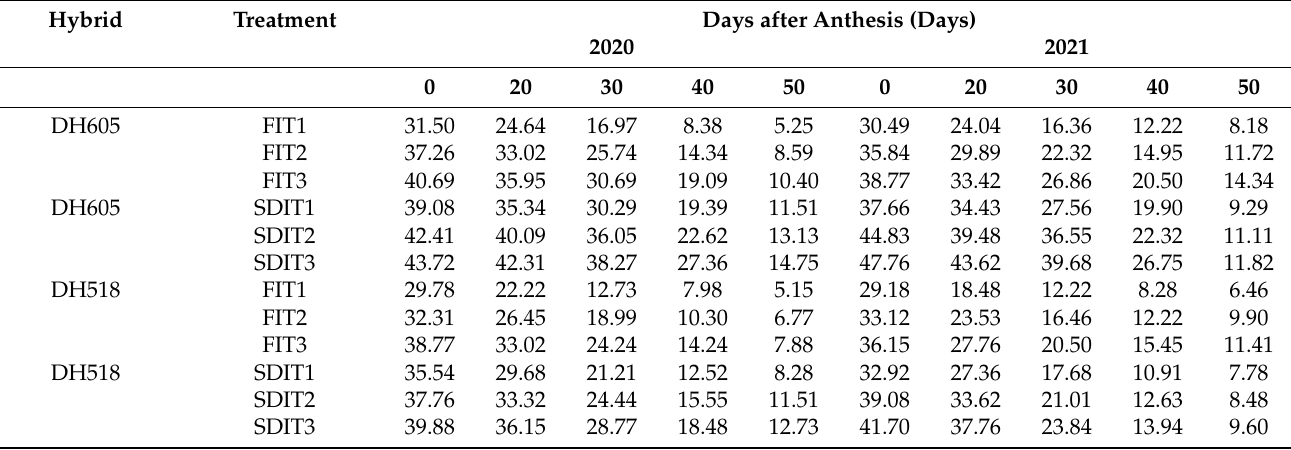
Table 6. Net photosynthetic rate (P n ) of two corn hybrids differing in maturity under different irrigation treatments ( µ mol CO 2 /(m 2 s)).